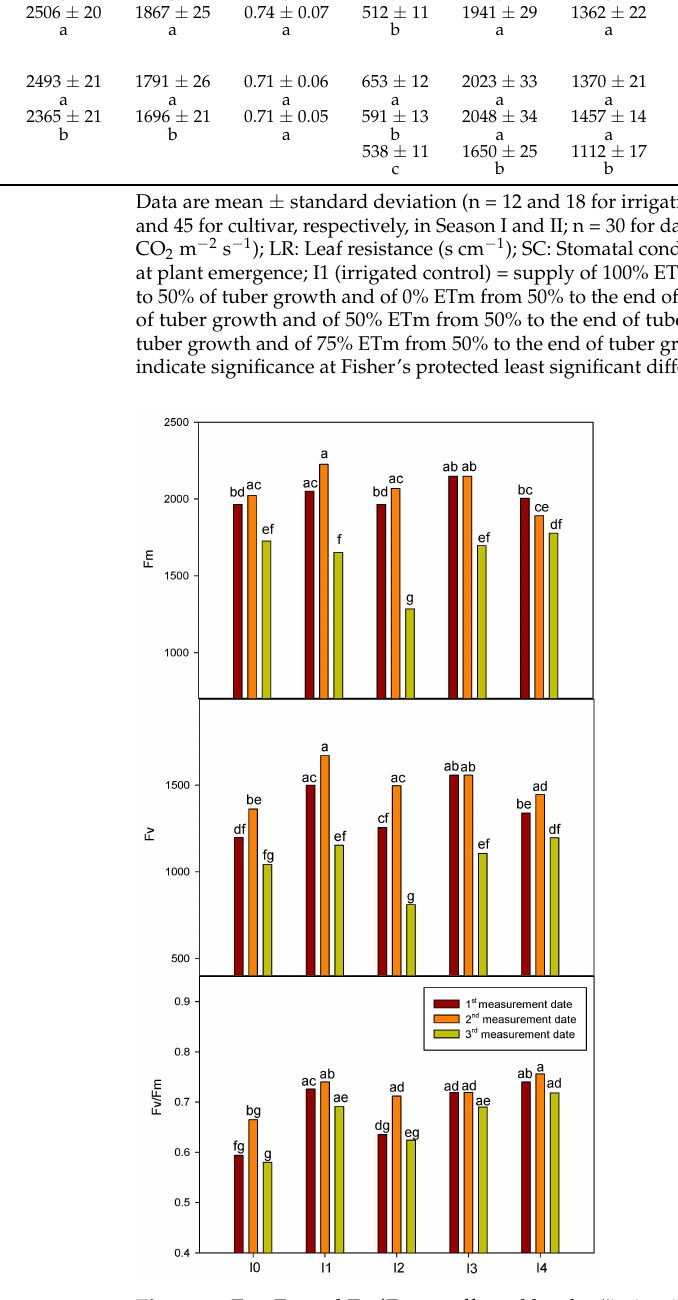
Figure 2. Fm, Fv and Fv/Fm as affected by the “irrigation regime × measurement dates” interaction in Season II. Different letters for each parameter indicate significant differences at p ≤